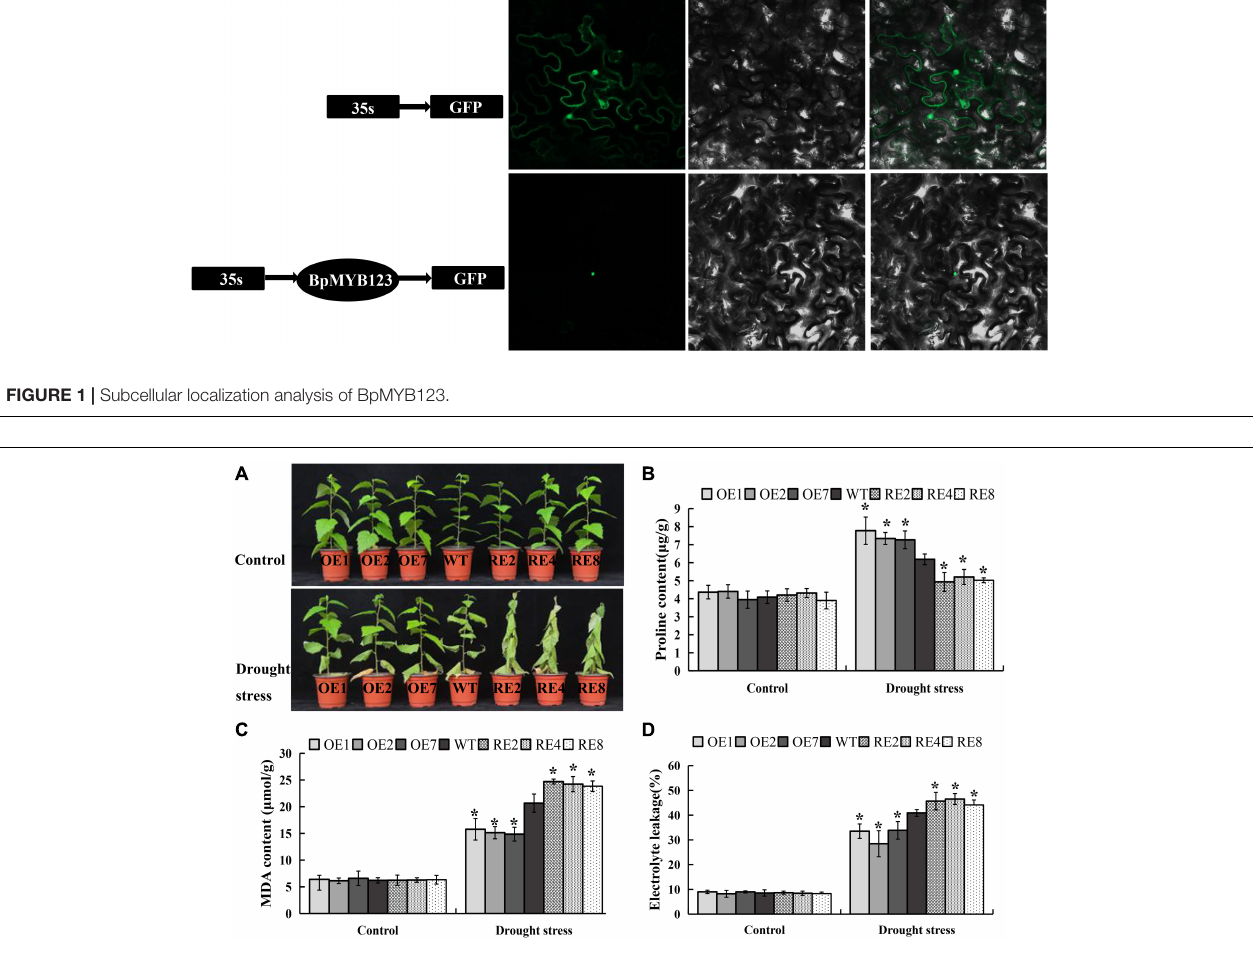
FIGURE 2 | Overexpression of BpMYB123 conferred enhanced drought tolerance in its transgenic lines. (A) Phenotypic comparison of BpMYB123 transgenic lines and wild-type plants under drought stress. (B) Content of proline. (C) Content of malondialdehyde (MDA). (D) The result of electrolyte leakage. Asterisks indicate significant differences by t -test, p <